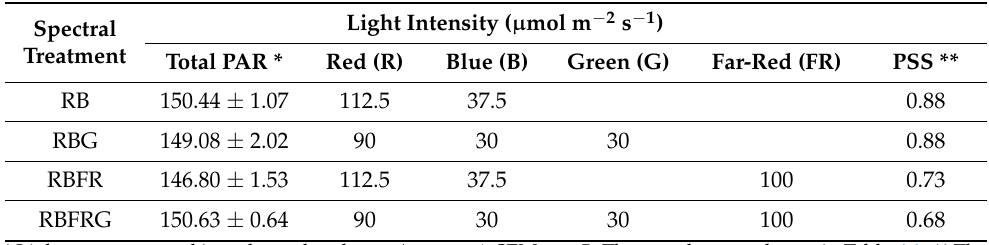
photon flux density (PFD; 400–800 nm) of blue (B; 400–500 nm), green (G; 500–600 nm), red (R; 600–700 nm), and far-red (FR; 700–800 nm) light and the phytochrome photostationary state (PSS) for the four spectral treatments in Experiment 1.